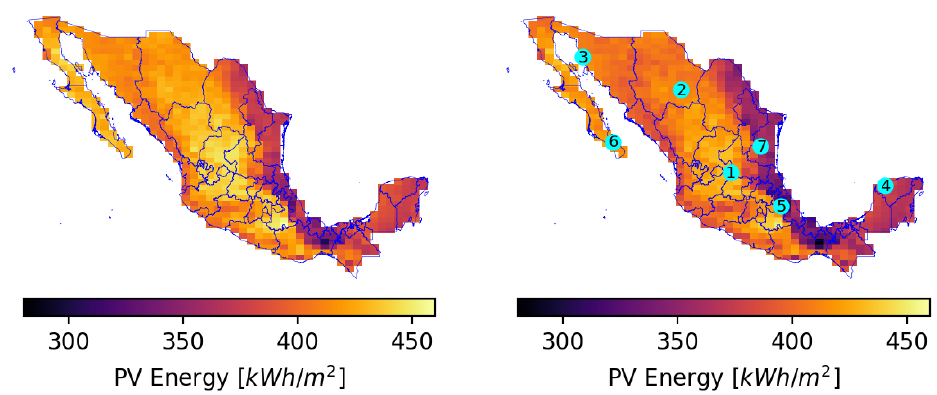
Figure 9. Atlases for the P 50– P 95 estimations of the annual PV energy per square meter in Mexico. The blue dots correspond to the location of the PV plants used for validation in Section 3.5.